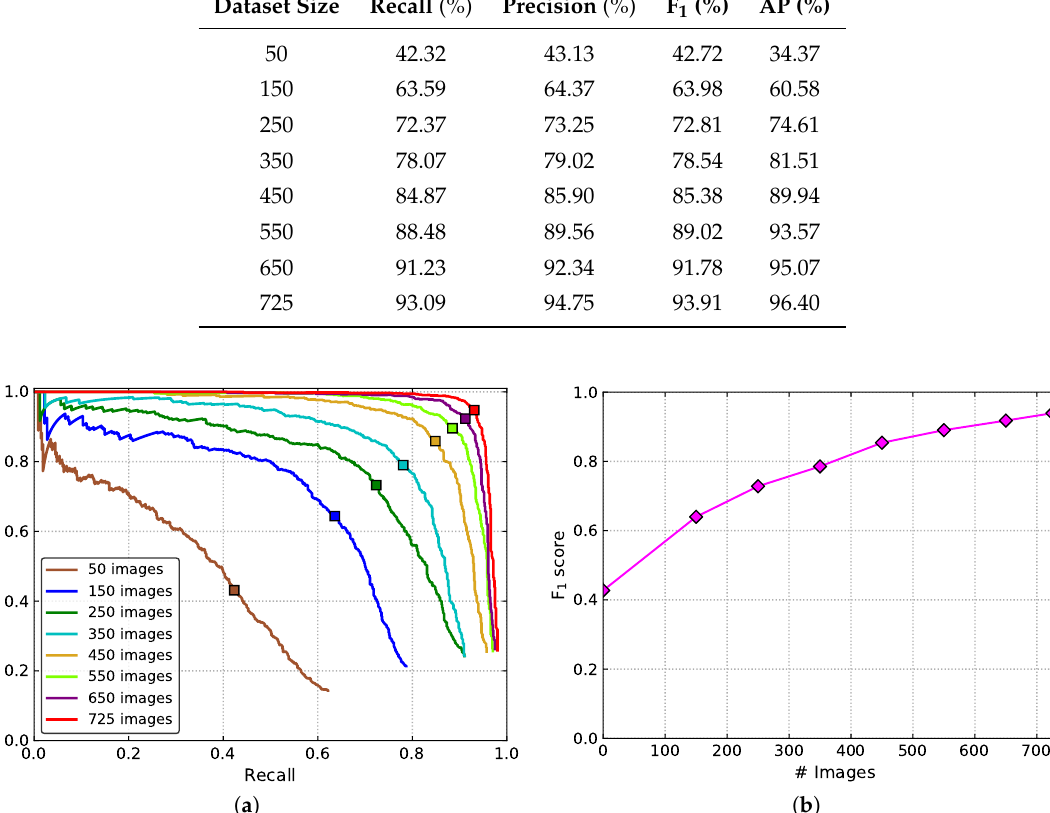
Figure 13. ( a ) P–R curves, and ( b ) the F 1 scores of the models trained with different size of datasets.